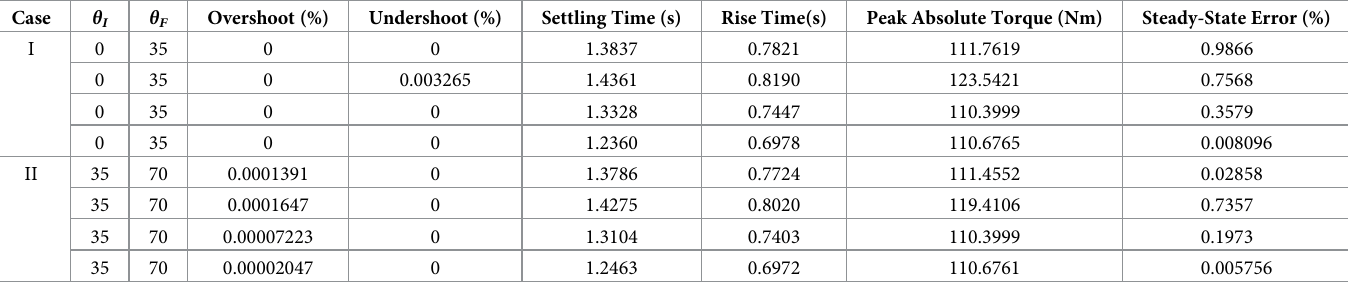
Table 3. Summary of results for LQR.